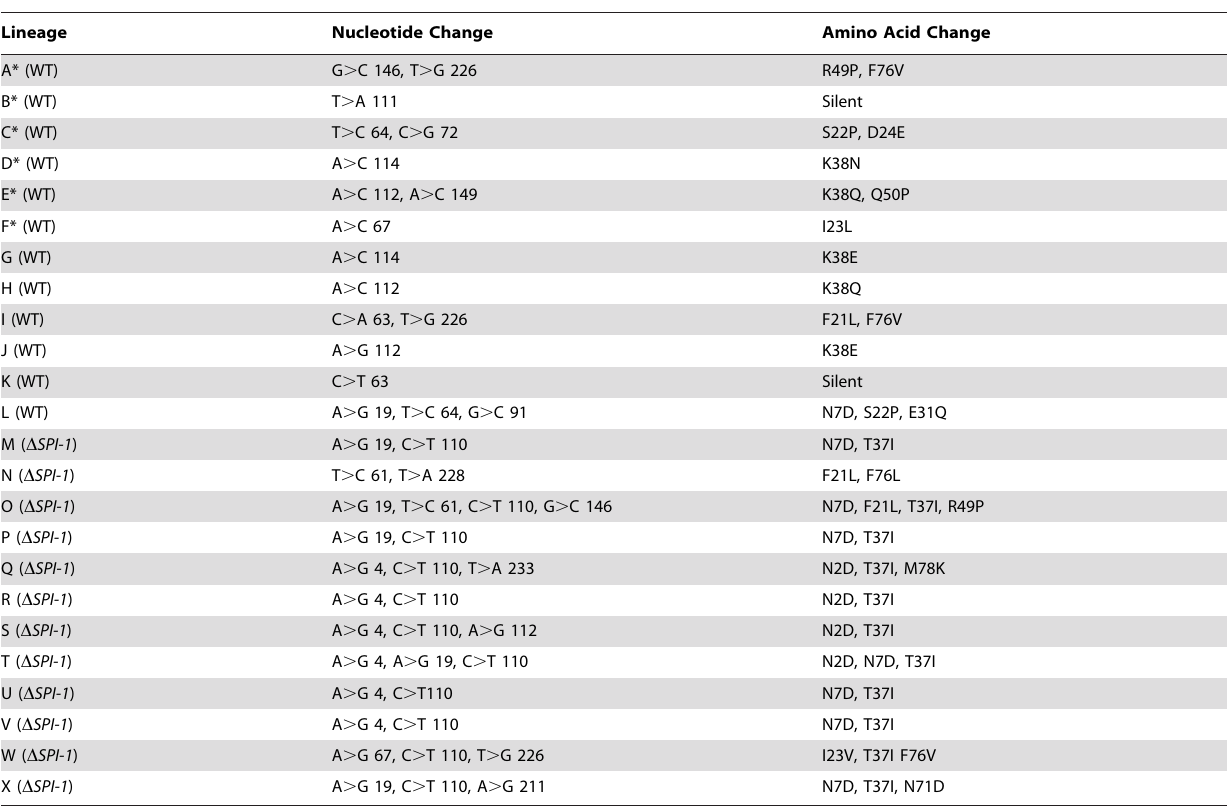
Table 3. Summary of stpA changes in second evolution experiment.